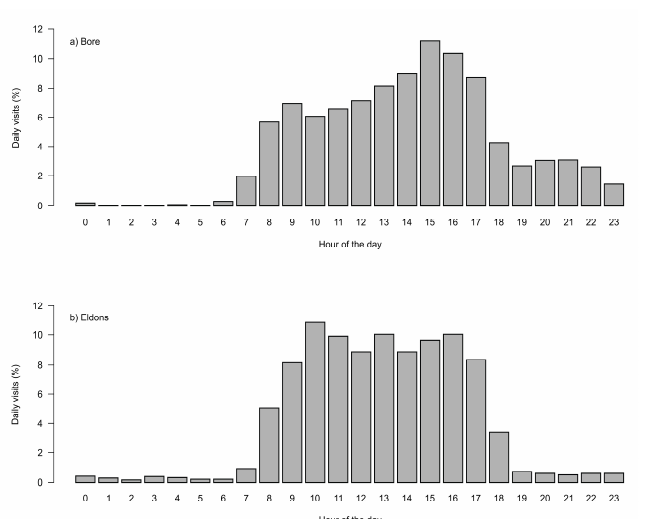
Figure 6. Frequency distribution of time of the visit to the automatic supplement weighing (ASW) units over a 24-h period in ( a ) Bore and ( b ) Eldons sites.